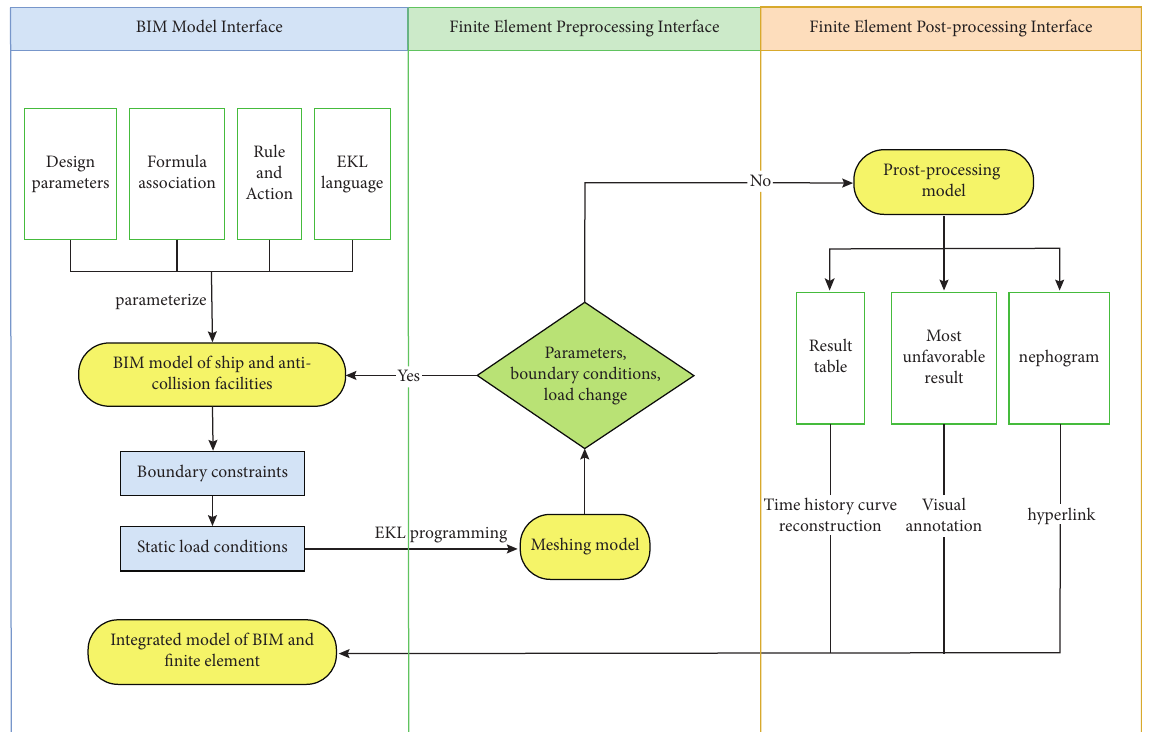
Figure 3: Technical roadmap of bidirectional communication between BIM model and finite element model of ship and buoyancy anti- collision